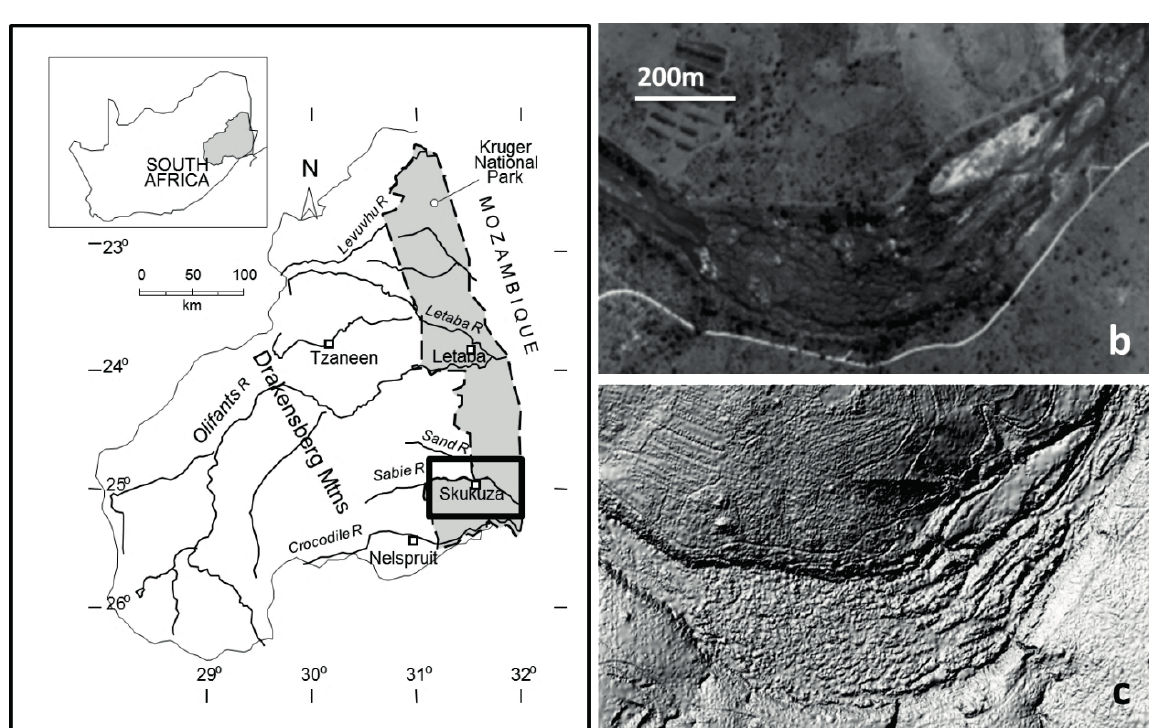
Fig. 1 (a) Location of the Sabie River, Mpumalanga Province, South Africa, and character of a mixed anastomosed reach on the river identified from (b) aerial imagery and (c) LIDAR DEM. Flow direction is from middle left to upper right.